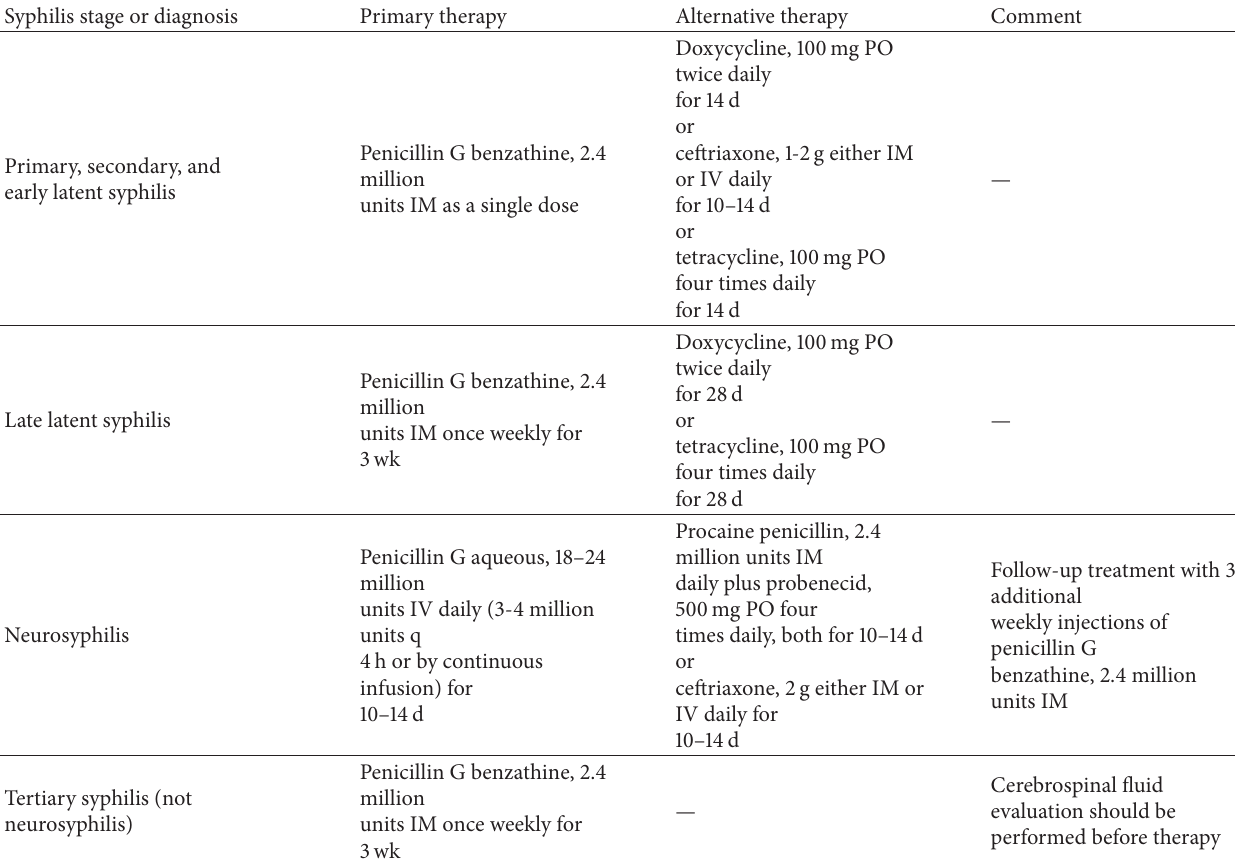
Table 2: Treatment of syphilis